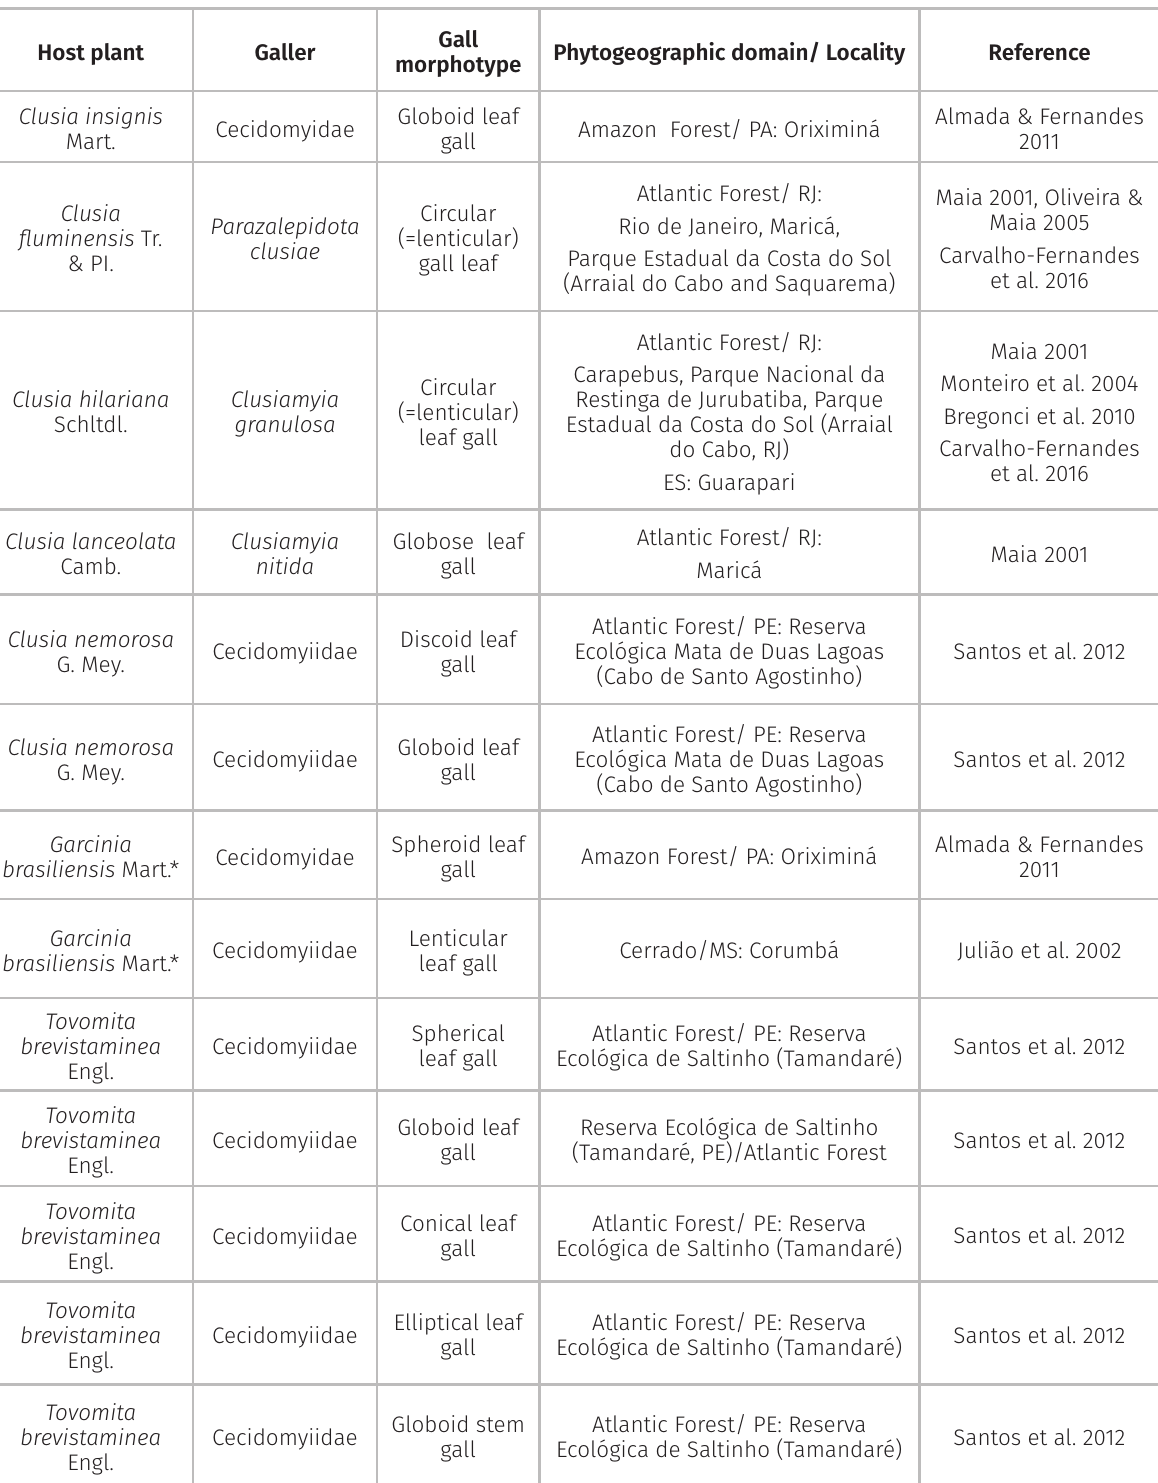
Clusia fluminensis